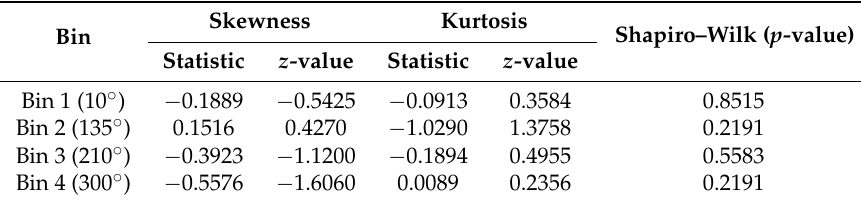
Table 3. A summary of descriptive statics and Shapiro–Wilk’s test for normal force coefficient at U ∞ = 5 m/s, Φ = 30°, and r/R = 0.30.